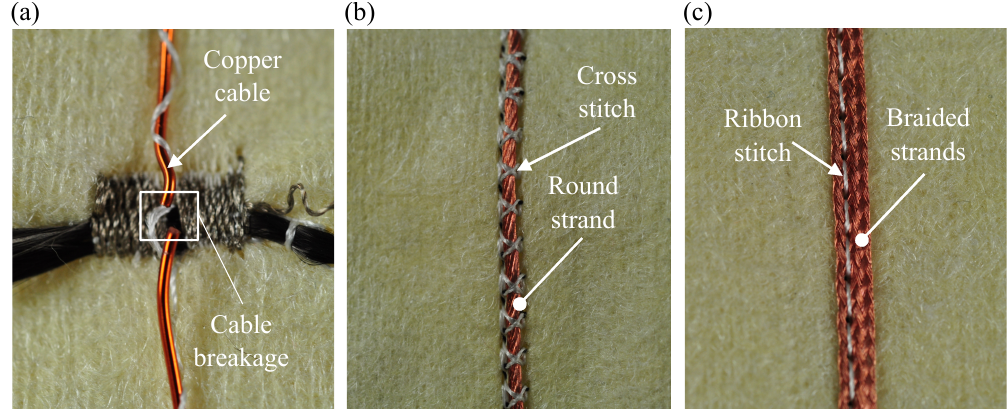
Figure 9. ( a ) Damaged copper cable; ( b ) copper strand fixed by cross stitch; and ( c ) copper braided strand fixed by ribbon stitch.